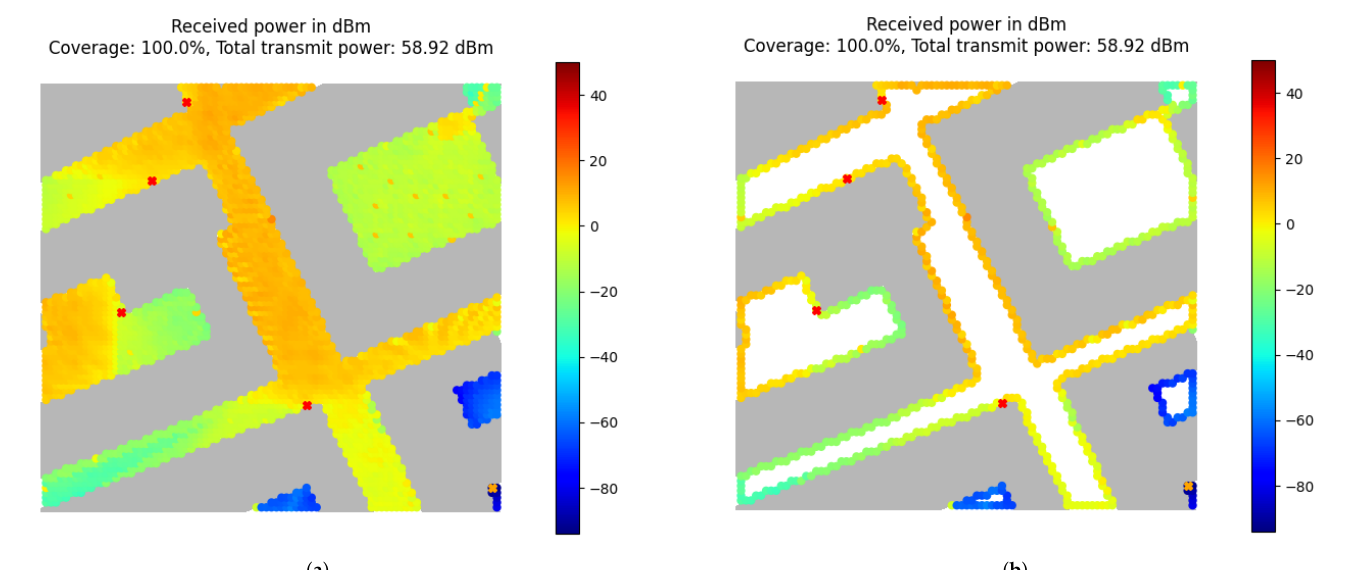
Figure 8. Comparison between the full coverage region and simplified coverage region regarding the total required transmit power. When considering a full coverage region or a simplified one, the total transmit power simulated via the RTS is very similar. This confirms that the simplified coverage region contains the user locations which receive the overall lowest channel gain. ( a ) Map 1; ( b ) Map 5.